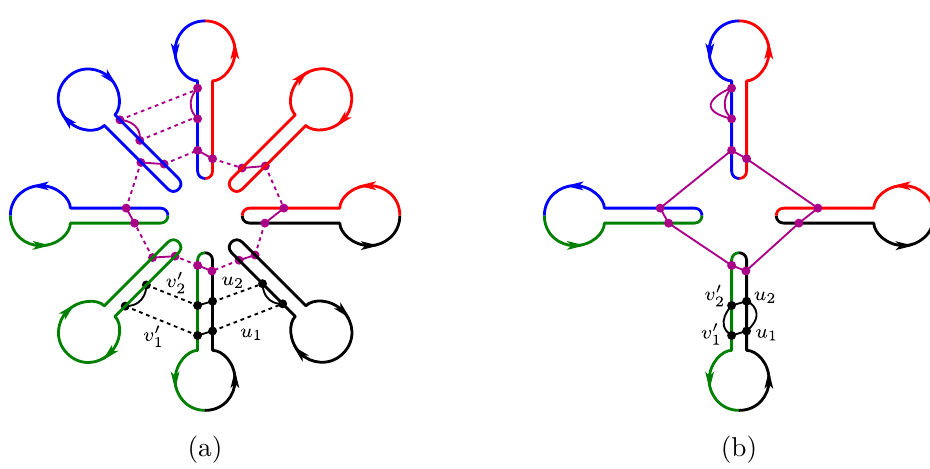
Figure 1 . (a) A diagram for Tr ( ρ B ∗ B ( t )) s , where ρ B ∗ B ( t ) is given by (2.4) and s = 4 . The thick solid lines make up 2 s Keldysh contours for the system and the bath in alternating order. Each half of a contour represents a thermofield-double. Lorentzian time is directed toward the center of the diagram. Different replicas are depicted in different colors. Wick contractions of fields are depicted by thin solid lines, while the dotted lines represent system-bath coupling. The leading contributions are due to purple loops; the shorter and the longer loops correspond to equations (2.11) and (2.12), respectively. (b) The simplified diagram obtained by omitting the bath’s